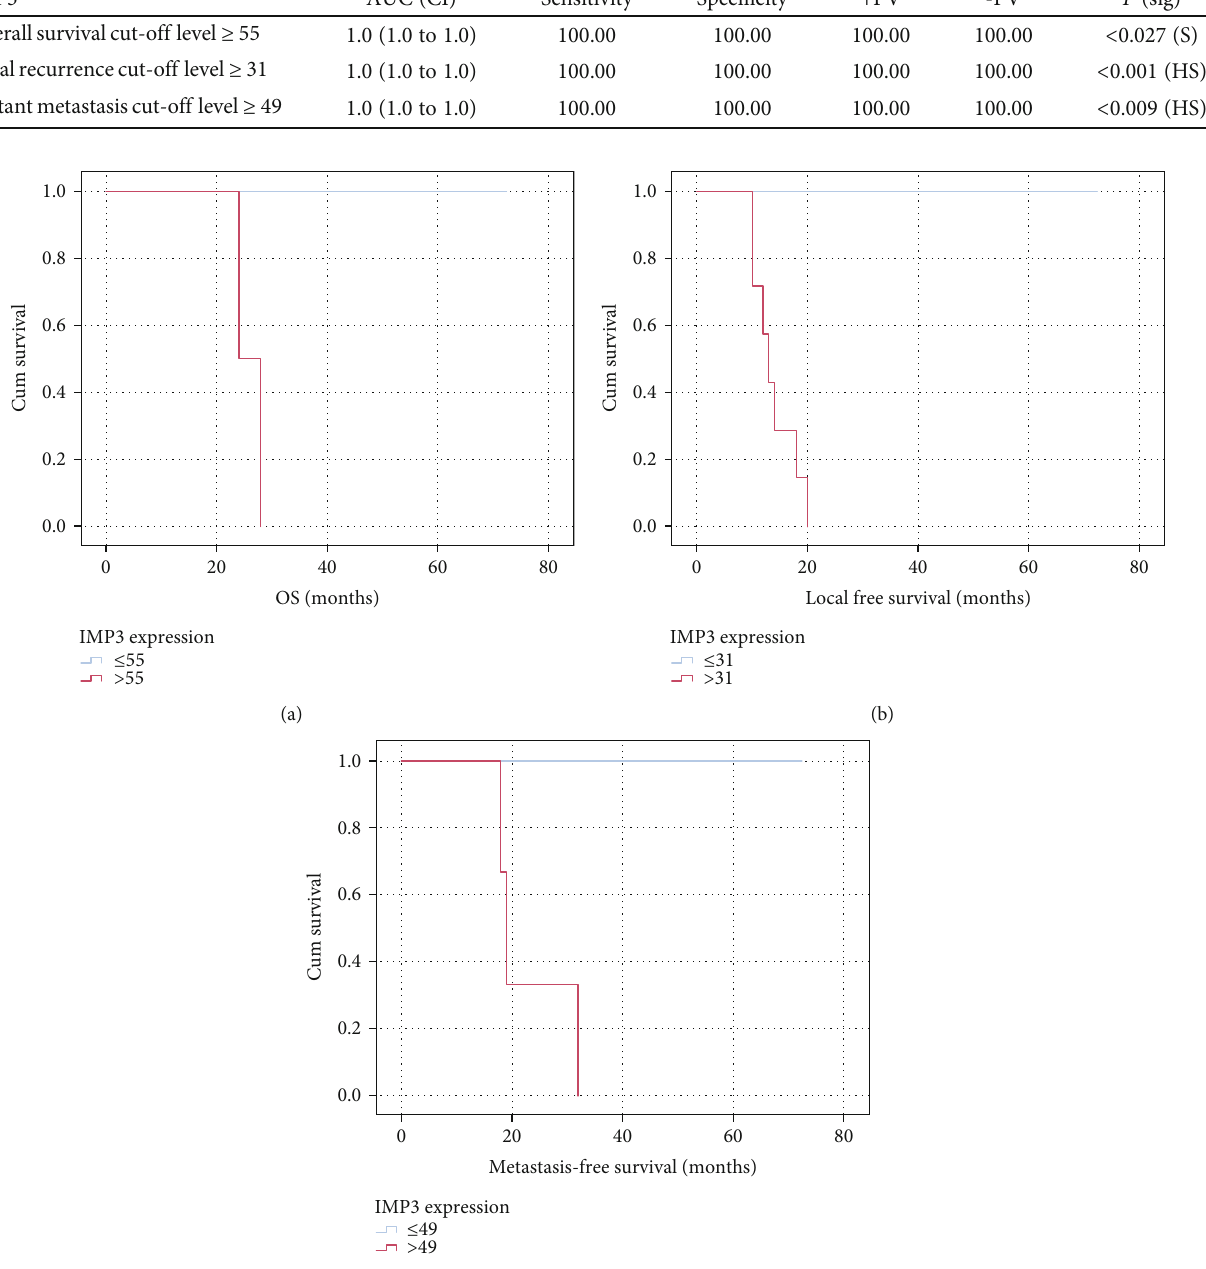
Table 7: ROC analysis using IMP3 to predict mortality, local recurrence, and distant metastasis among SCC cases. IMP3